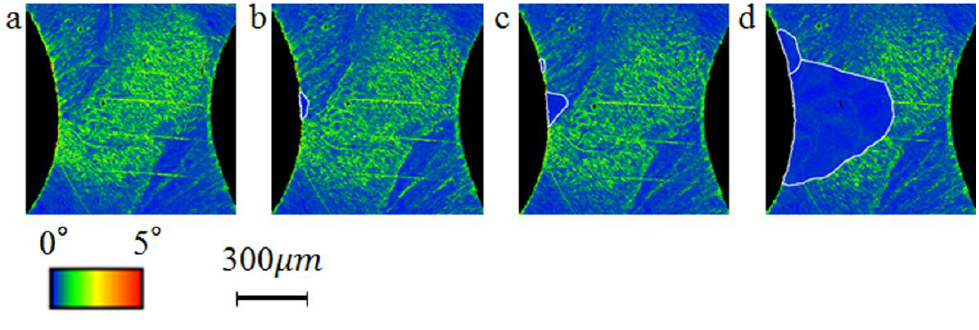
Figure 12. Microstructure evolution of specimen 3-1 at annealing time ( a ) 0 min; ( b ) 12.83 min; ( c ) 15 min; and ( d ) 60 min. Grain boundaries were highlighted with white lines.